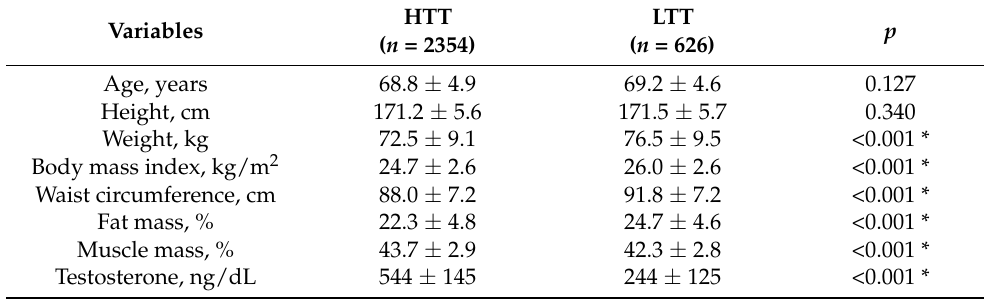
Table 1. Comparison between high testosterone and low testosterone.